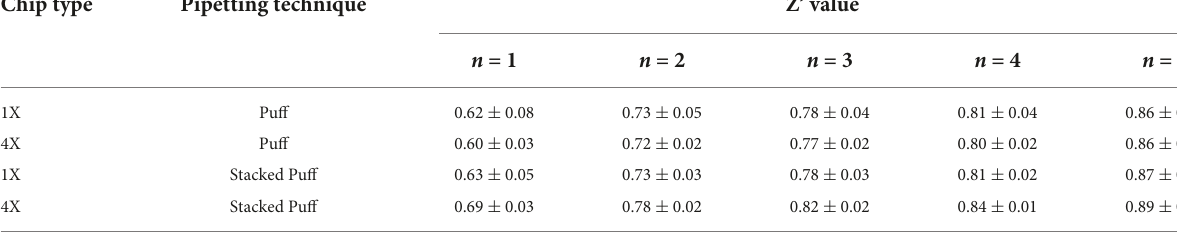
TABLE 5 Comparison of SP384i ASIC1a assay performance in single vs. multi-hole chips.